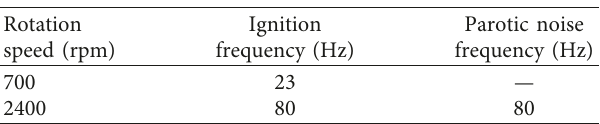
Figure 9: Amplitude spectrum of vibration at the back panel. Table 2: Ignition